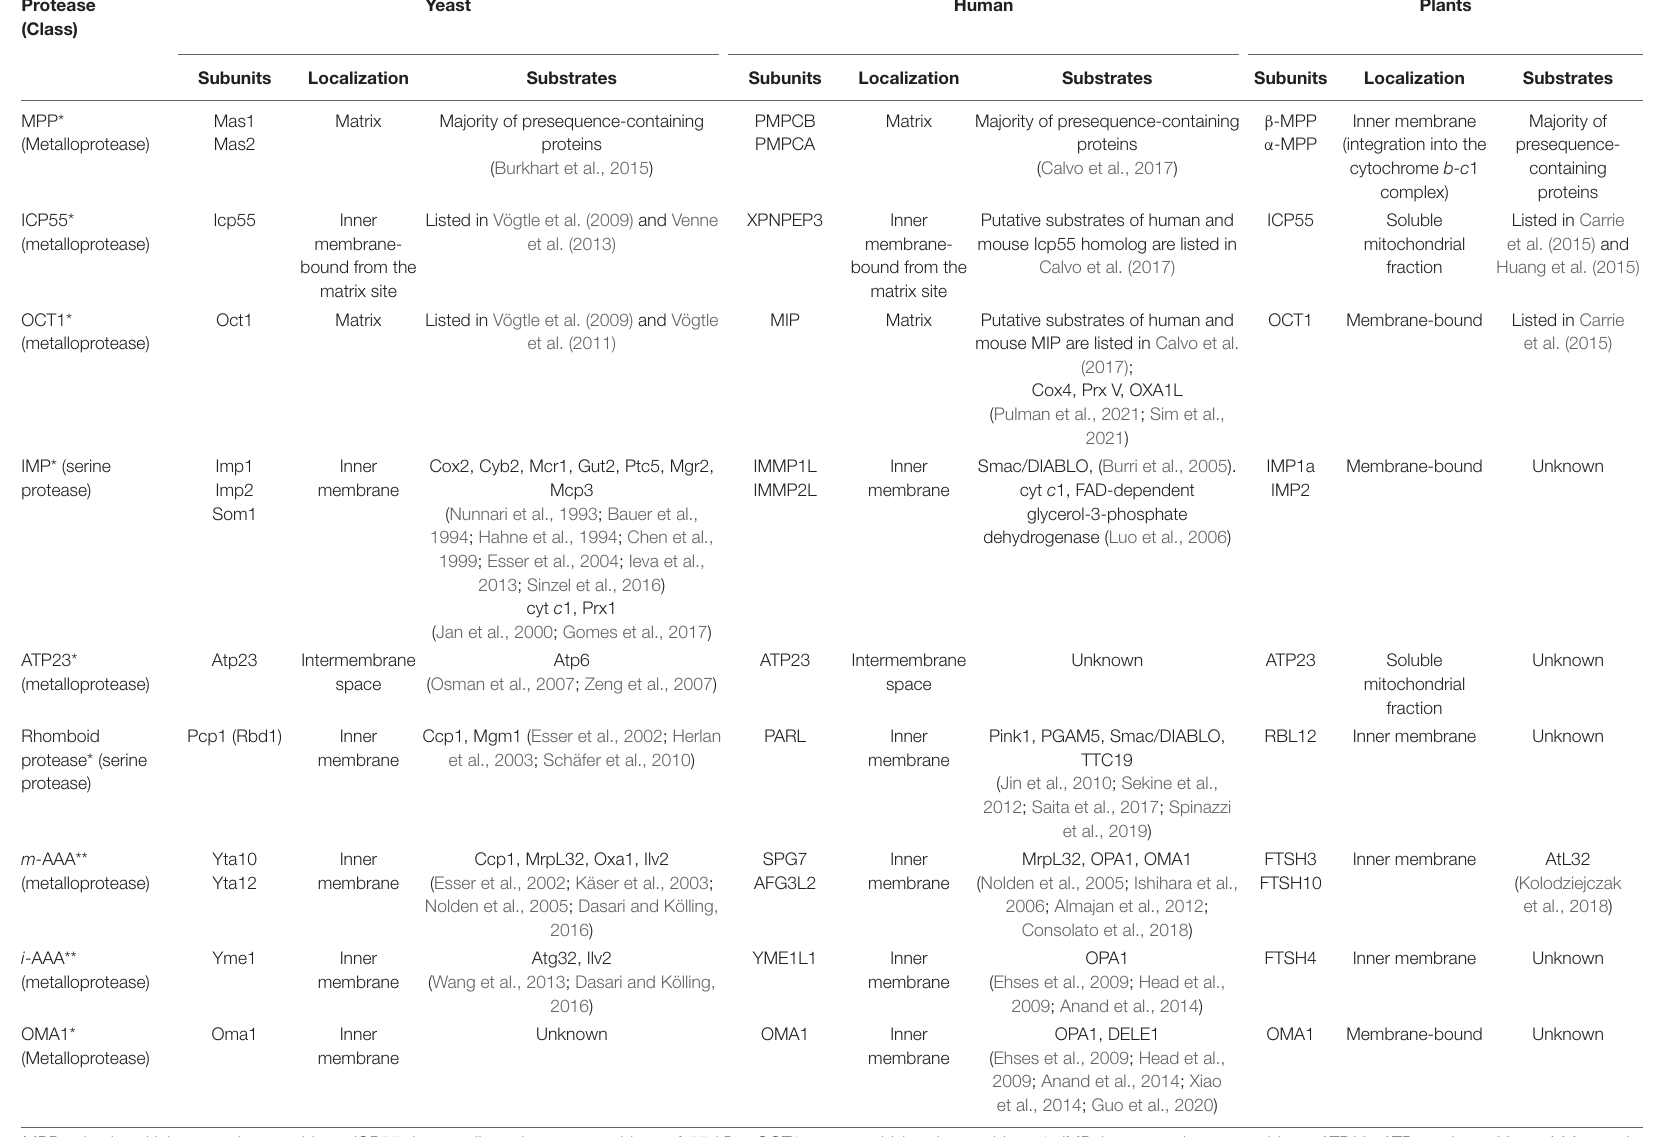
TABLE 2 | Mitochondrial proteases involved in limited proteolysis and their substrates in yeast, mammalian, and plant mitochondria. Protease